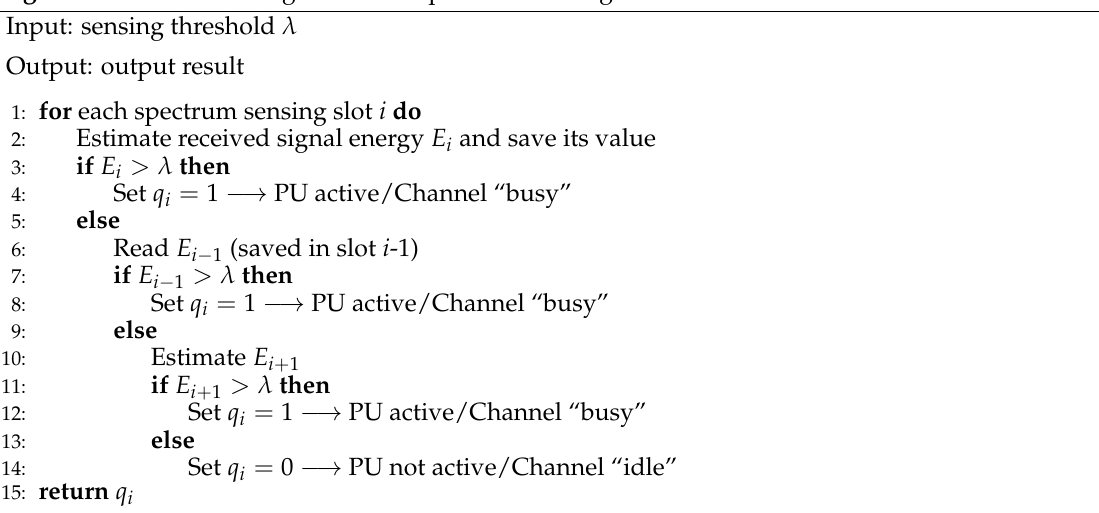
Algorithm 1 The 3EED Algorithm for Spectrum